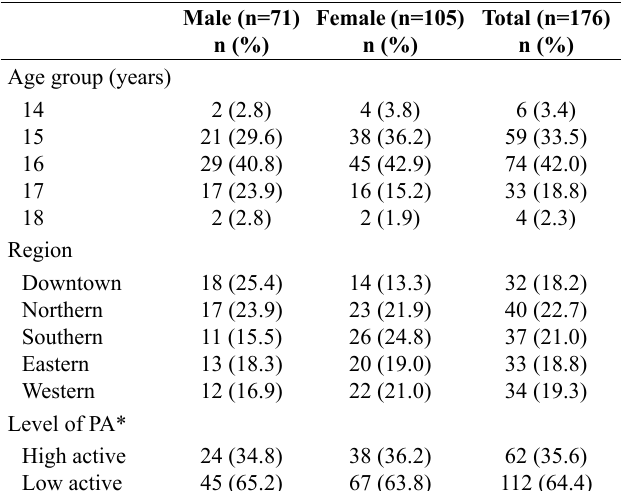
Table 1. Characteristics of participants stratified by